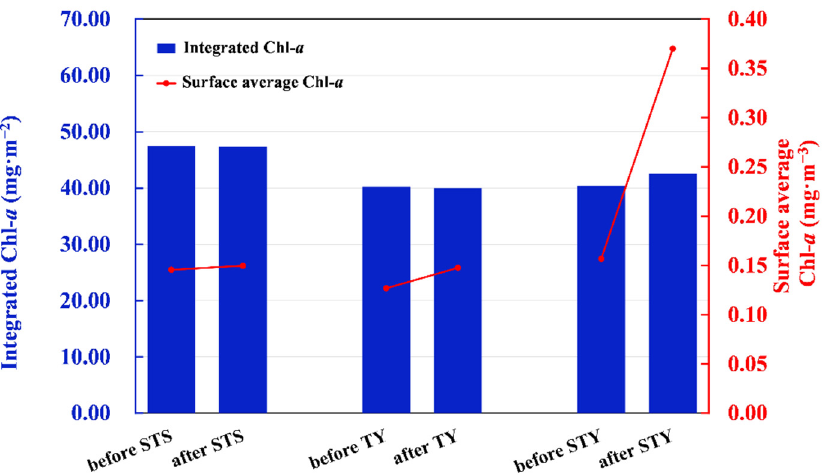
Figure 7. Chl- a concentration changes before and after the transit of STS, TY and STY. The histogram showed the depth-integrated Chl- a in the black box (Figure 1) of the study areas before and after the tropical cyclones. The red dotted line graph showed the average Chl- a concentration in the surface area of the study area before and after the tropical cyclones.